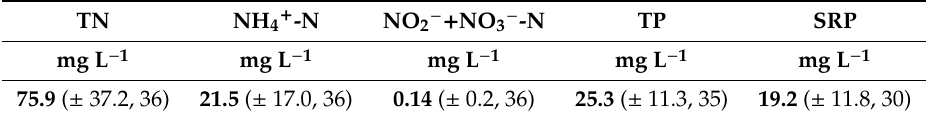
Table 1. Mean nitrogen (N) and phosphorus (P) concentrations of silage bunker runoff for System Inflow samples for 36 storm events from 2018–2019 (standard deviation and sample size in parentheses). TN = total N, NH 4+ -N = ammonium-N, NO 2 - +NO 3 - -N = nitrite + nitrate-N, TP = total P, SRP = soluble reactive P.